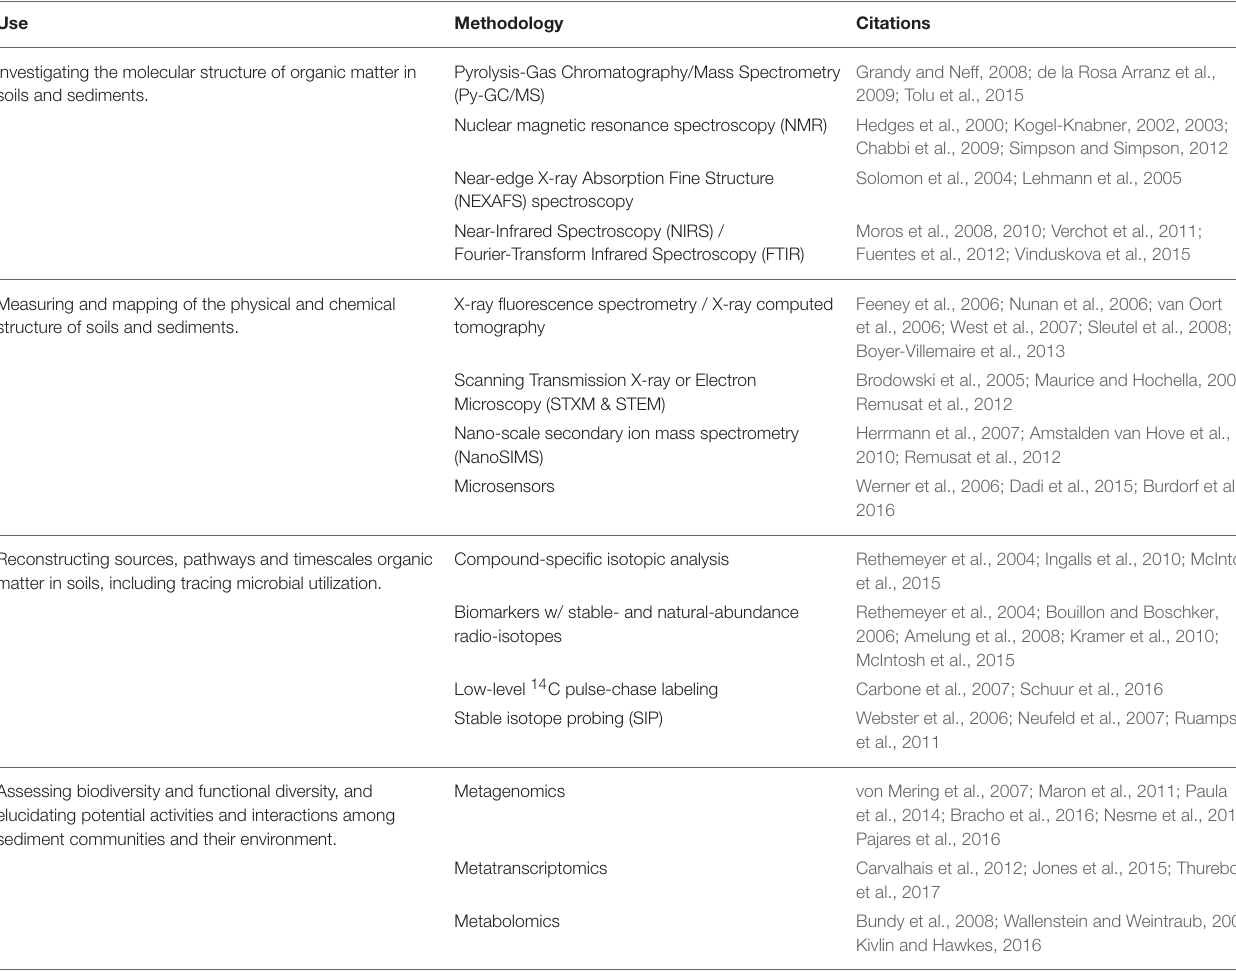
TABLE 1 | Some of the existing methodologies utilized to aid in the understanding of organic carbon stabilization in soils and sediments.